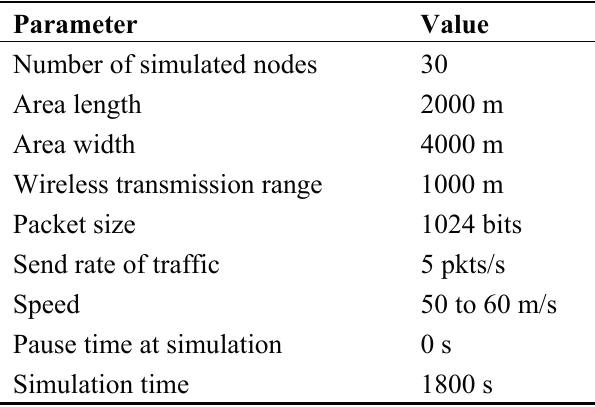
Table 1. Simulation parameters.